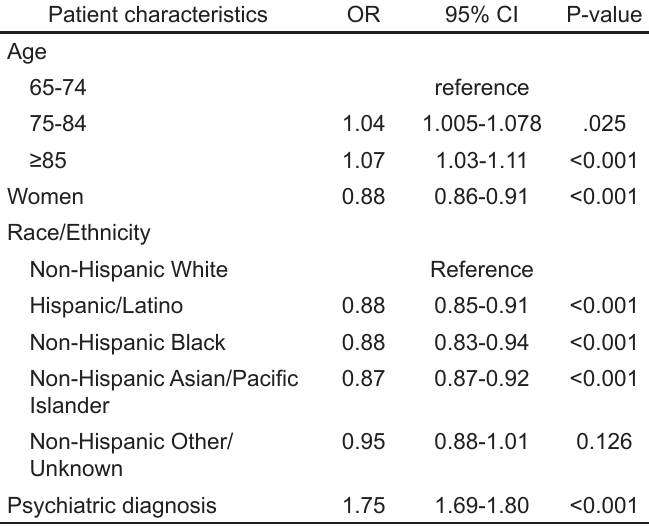
OR, odds ratio, CI, confidence